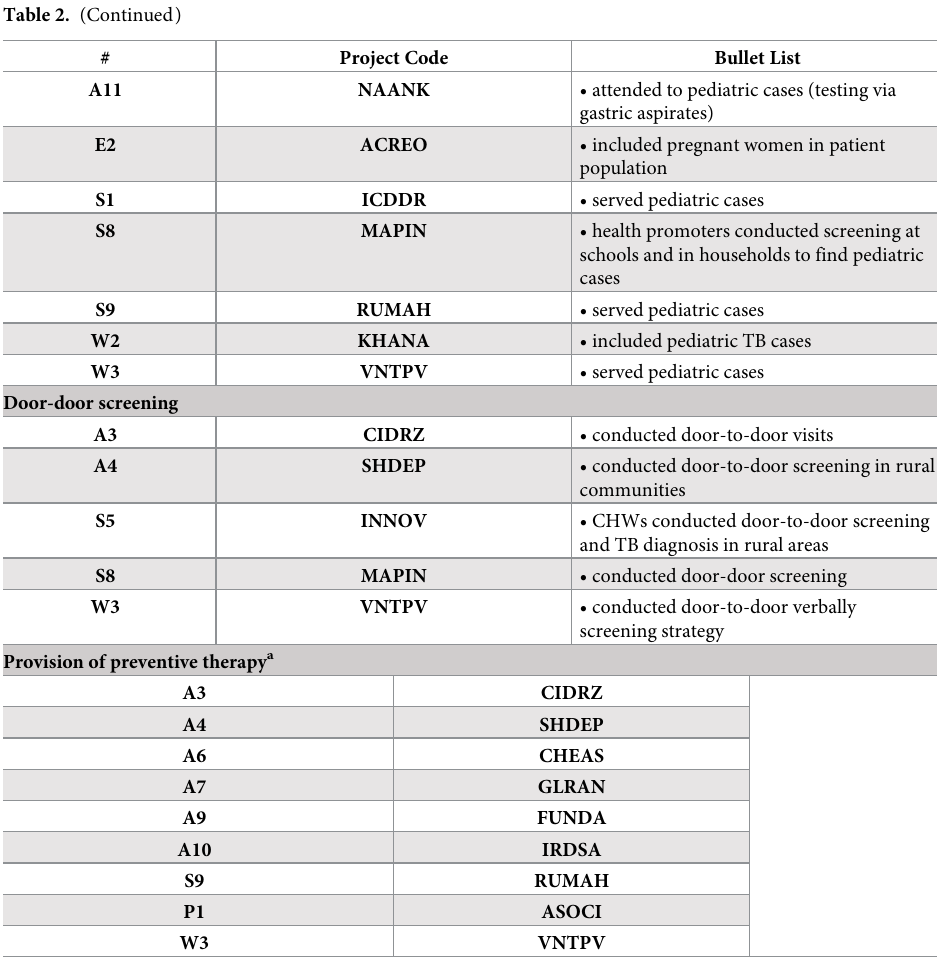
(Table 3 and S1-S4 Tables in S1 File): 1) case finding (cost per patient diagnosed), 2) linkage- to-care (cost per patient referred for treatment), and 3) patient support (cost per patient com- pleting treatment). For projects reporting programmatic activities beyond case finding (i.e., activities for linkage to care and/or treatment adherence), we assessed cost estimates for each programmatic activity by first assessing expense records specific to each activity (e.g. Xpert cartridge costs were considered specific to case finding costs only) and then adding appor- tioned shared costs based on the ratios of programmatic outputs for each major activity